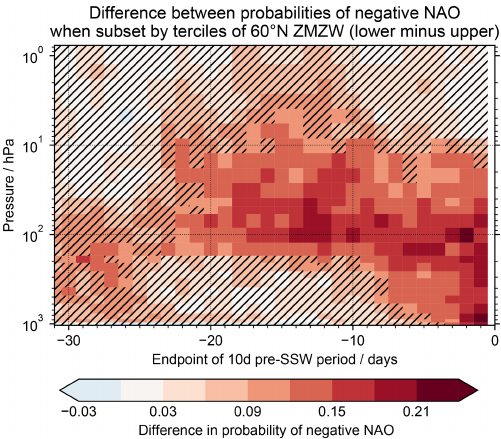
Figure 5. Effect of zonal-mean zonal-wind (ZMZW) precursors on the NAO response to SSWs. The shading shows the difference in the probability of a negative NAO response, between selecting lower and upper thirds of the ZMZW, at each pressure level and pre-SSW lead time. Points are coloured on the final day of the 10d pre-SSW period they use. Points are hatched out when the difference is sta- tistically indistinguishable from